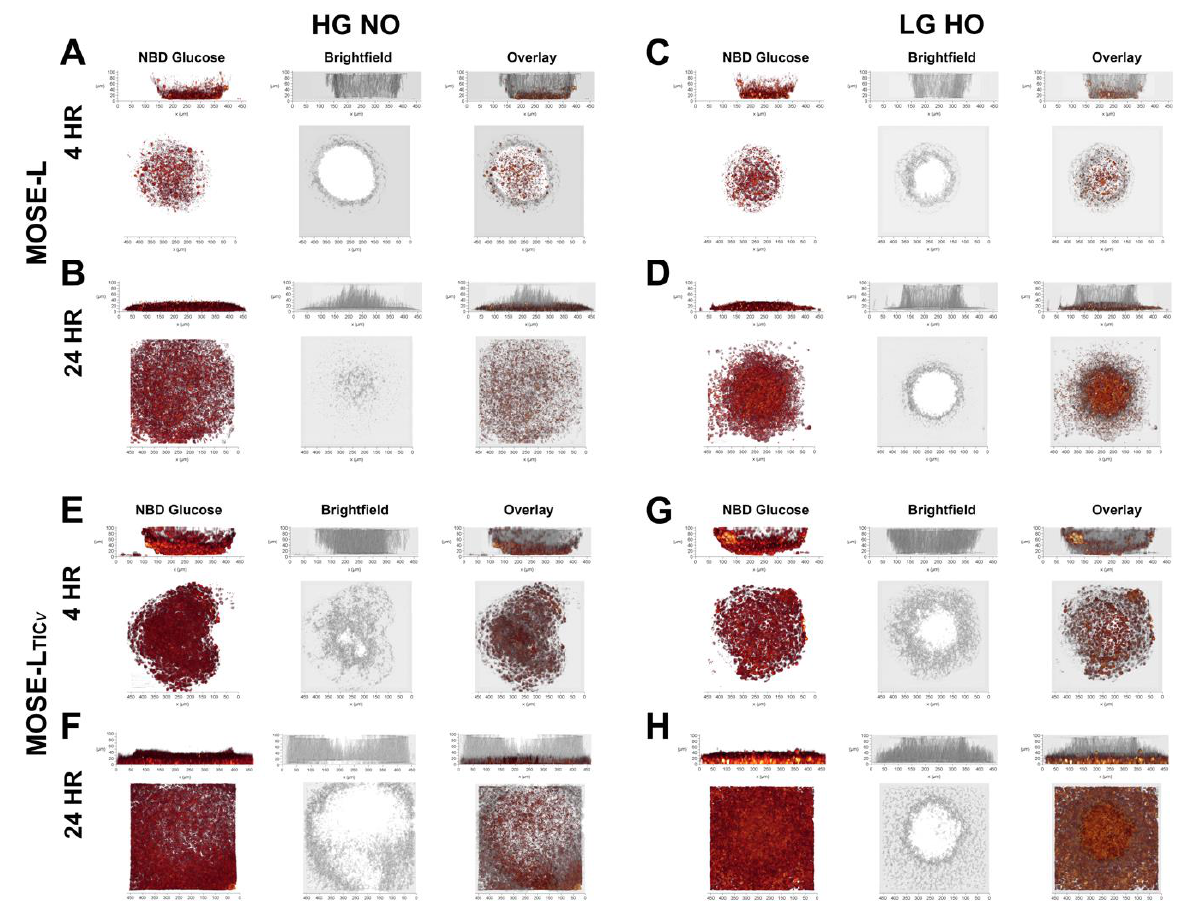
Figure 4. Glucose uptake in spheroids at 4 and 24 h in different conditions. Images represent 3D reconstructions of confocal imaging and reconstruction of NBD-glucose, brightfield, and overlay. Measurements were taken in MOSE-L and MOSE-L TICv spheroids in HG NO and LG HO at 4 and 24 h of adherence. Spheroids are displayed as viewed from the side (top image) and from the top (bottom image). ( A ) MOSE-L 4 h HG NO ( B ) MOSE-L 24 h HG NO ( C ) MOSE-L 4 h LG HO ( D ) MOSE-L 24 h LG HO ( E ) MOSE-L TIC v 4 h HG NO ( F ) MOSE-L TIC v 24 h HG NO ( G ) MOSE-L TIC v 4 h LG HO ( H ) MOSE-L TIC v 24 h LG HO. Abbreviations: high glucose (HG); low glucose (LG); normoxia (NO); hypoxia (HO).